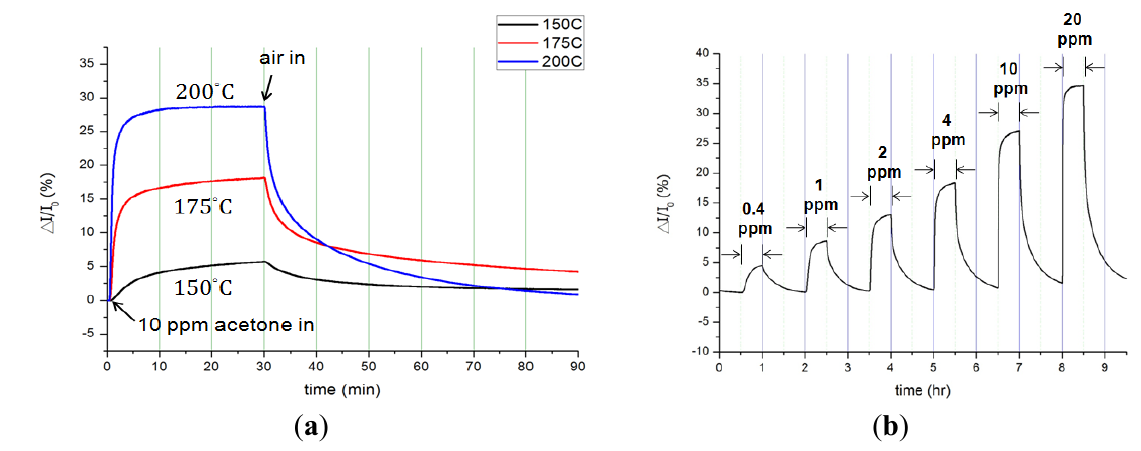
), and response/recovery times 0